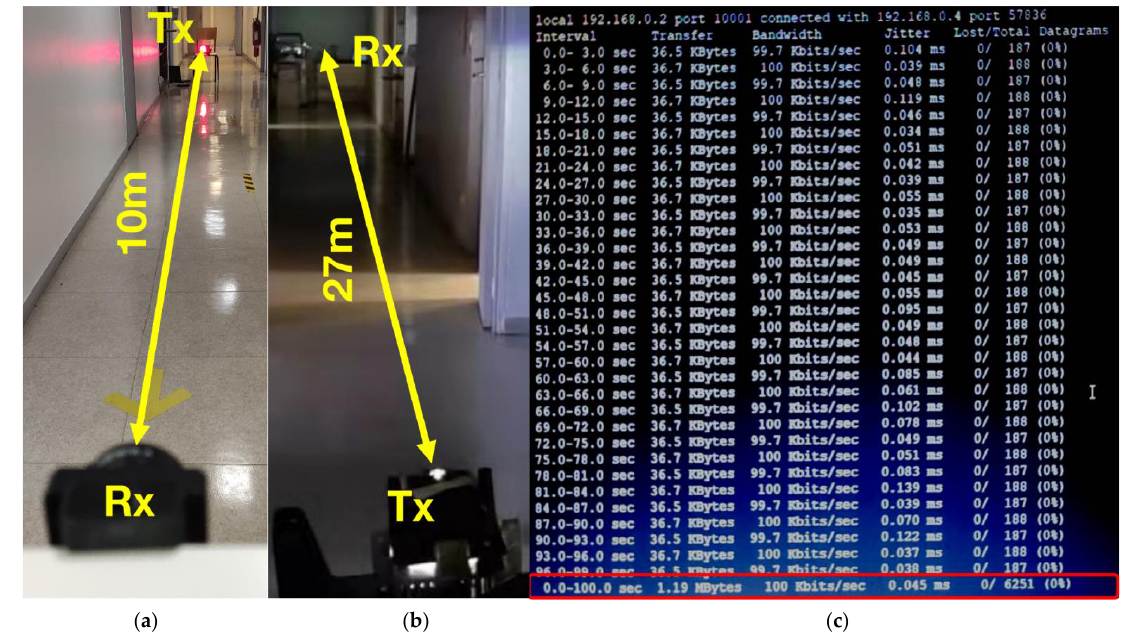
Figure 11. Experimental setup showing the VLC system communication range and communication parameters: ( a ) setup with a vehicle tail-light VLC transmitter enabling a 10 m communication range; ( b ) setup with a headlamp transmitter enabling a 27 m communication range; ( c ) screenshot of iperf tool showing a 100 kbps data rate and no lost datagrams.